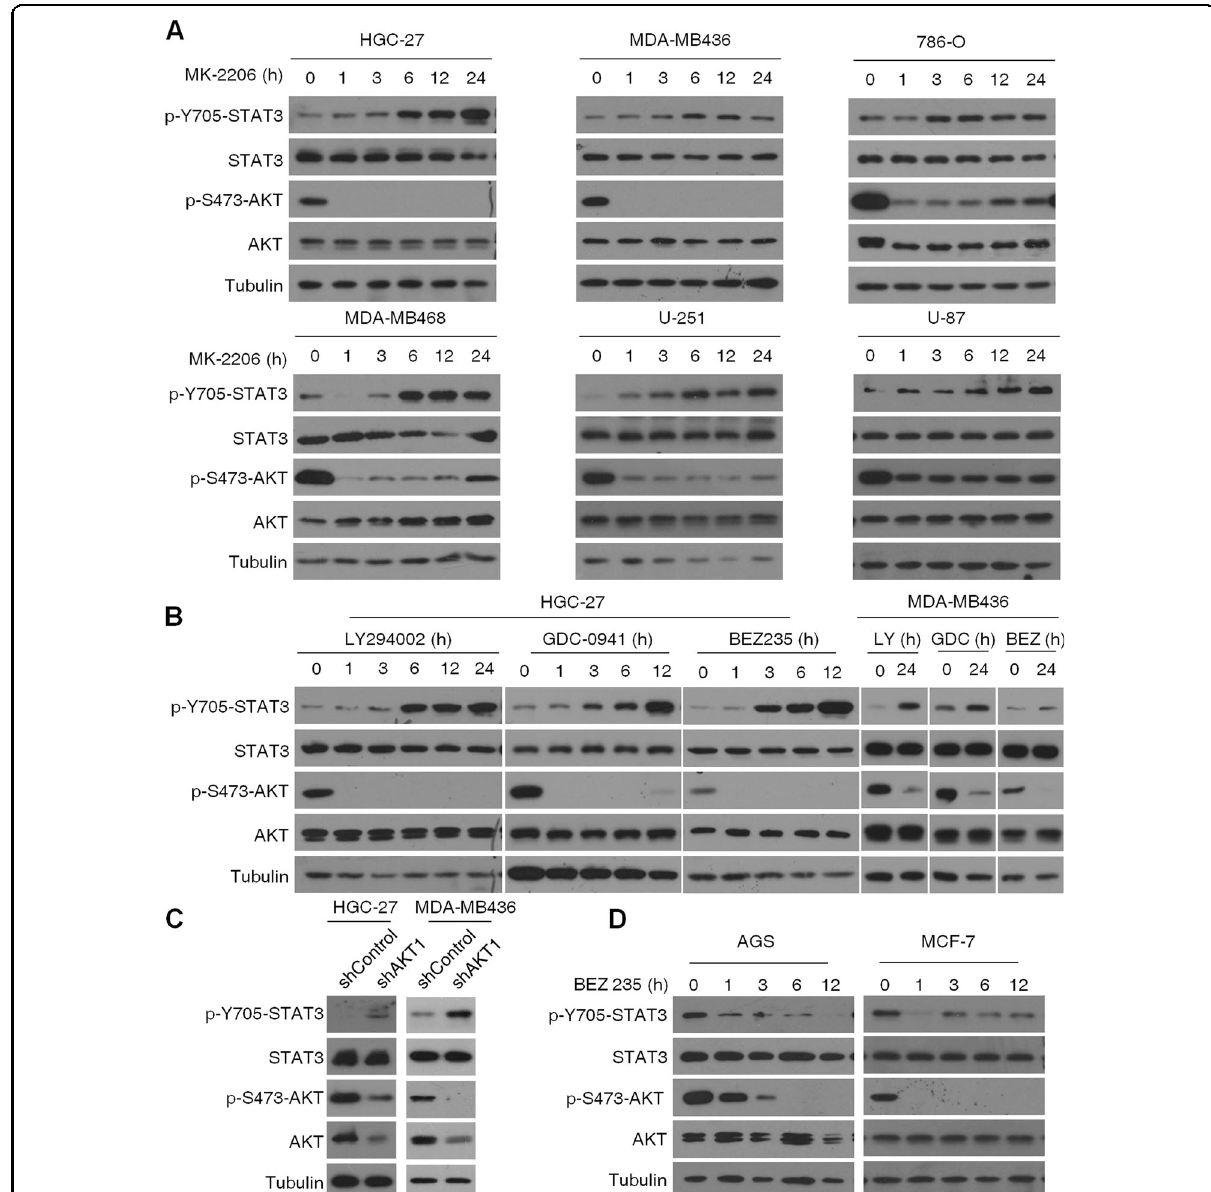
Fig. 2 Inhibition of the PI3K/AKT/mTOR signaling pathway in PTEN-de fi cient cancer cells activates STAT3. A Immunoblot showing expression levels of p-STAT3, T-STAT3, p-AKT, and T-AKT in HGC-27, MDA-MB-436, 786-O, MDA-MB-468, U87, and U251 cells treated with 1 µM MK-2206 for varying durations. B Immunoblot showing expression levels of p-STAT3, T-STAT3, p-AKT, and T-AKT in HGC-27 (left panel) and MDA-MB-436 cells (right panel) treated with LY294002 (40 μ M), GDC-0941 (1 μ M), or BEZ235 (100 nM) for the indicated durations. C Immunoblot showing expression levels of p-STAT3, T-STAT3, p-AKT, and T-AKT in AKT1-knockdown HGC-27 and MDA-MB436 cells. D Immunoblot showing expression levels of p- STAT3, T-STAT3, p-AKT, and T-AKT in AGS and MCF-7 cells treated with BEZ235 (100nM) for the indicated